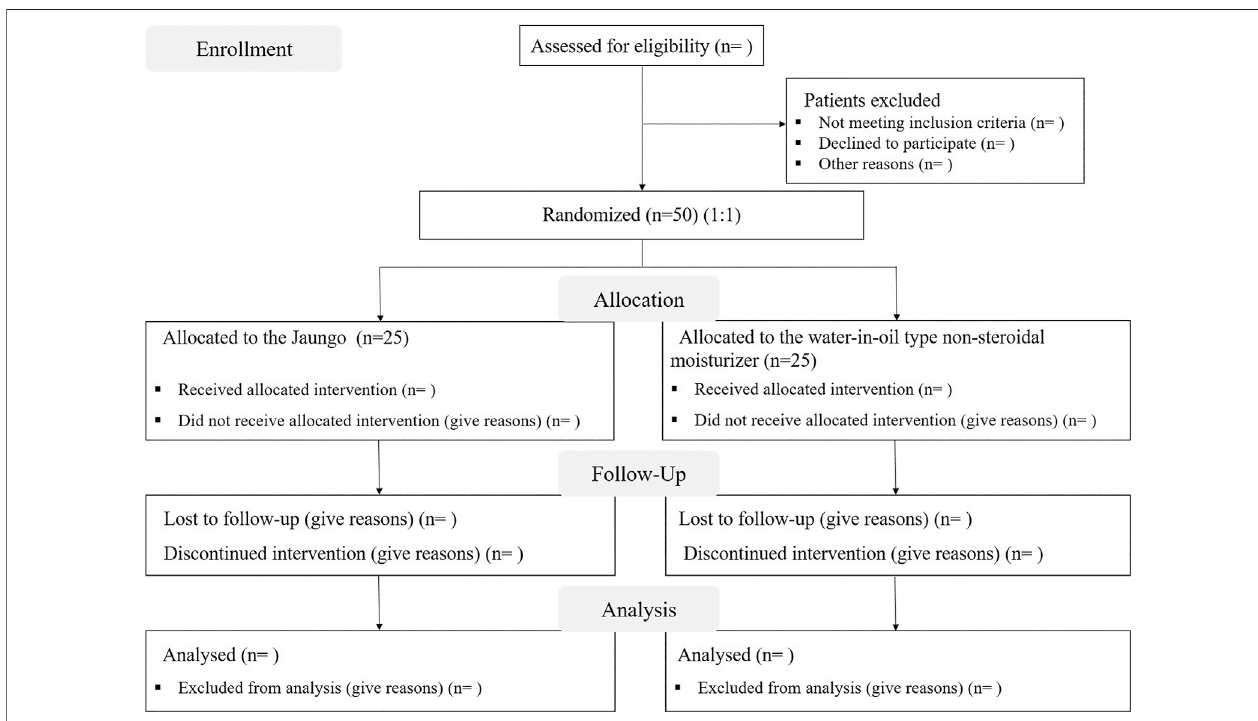
FIGURE 1 | SPIRIT fl ow diagram of the study